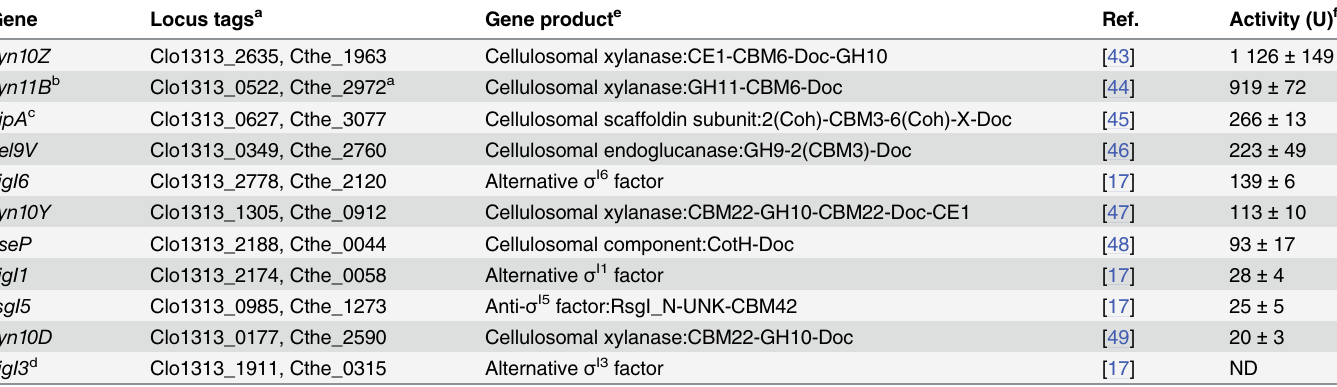
Table 3. Quantitative evaluation of possible promoters under the control of C . thermocellum σ I6 . Gene Locus tags